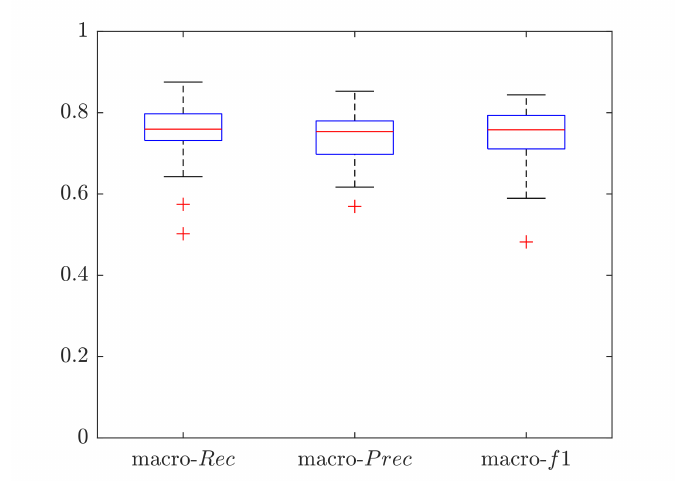
Figure 9. Classification results in terms of macro-average metrics obtained when classifying the full length (10-min long) LDV signals using a Support Vector Machine (SVM). Results are shown in terms of: macro recall (macro- Rec ), macro precision (macro- Prec ), and macro f1-score (macro- f